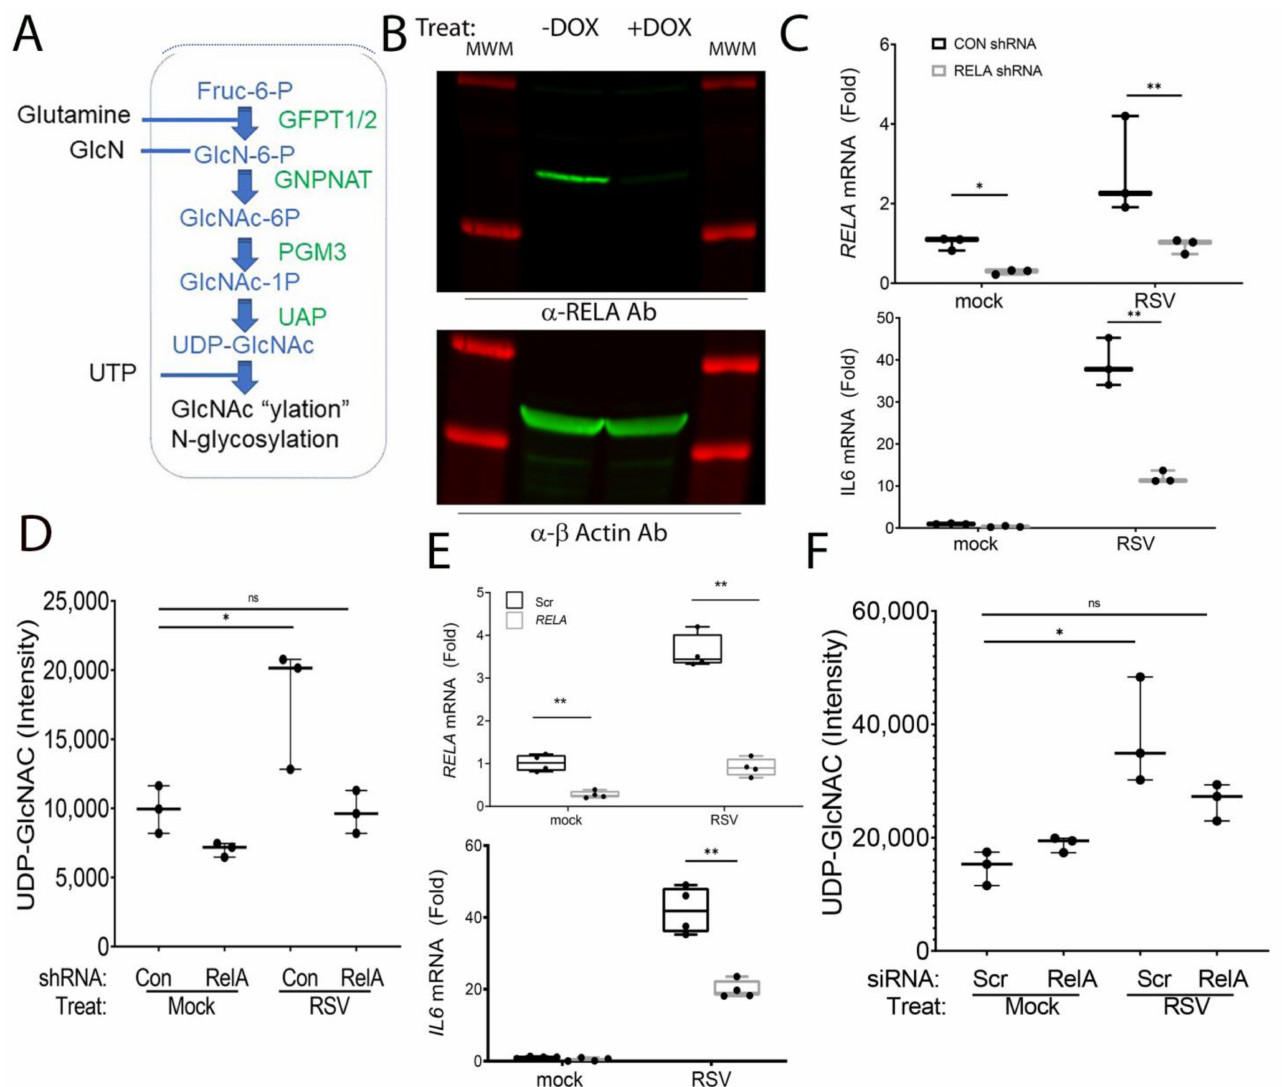
Figure 1. RELA regulates UDP-GlcNAc synthesis. ( A ) Schematic view of the HBP pathway from Fructose-6 phosphate (Fruc-6P) to the formation of UDP-GlcNAc. Metabolites are colored in blue; enyzmes are green. UDP-GlcNAc is a donor for the N-glycosylation of extracellular matrix (ECM) proteins, as well as protein GlcNAc-ylation. Abbreviations are: GFPT, Glutamine-Fructose-6- Phosphate Transaminase; PGM, phosphoglucomutase; UAP, UDP-N-Acetylglucosamine Pyrophos- phorylase; and GNPNAT, Glucosamine-Phosphate N-Acetyltransferase. ( B ) Western blot of RELA in doxycycline-regulated hSAECs. Cells were cultured in the absence (-) or presence (+) of DOX before whole cell lysis. Top panel, anti-RELA staining (green); bottom panel, β -actin staining (green) as housekeeping control. The prominent 65kDa RELA staining is depleted after DOX treatment. MWM, molecular-weight markers (red). ( C ) qRT-PCR. Cells cultured in the absence or presence of DOX were mock-infected or RSV-infected for 24 h prior to qRT-PCR. Data are expressed as a fold change of the untreated control, normalized to PP1A. Each symbol is a biological replicate ( n = 3). Top panel, RELA mRNA; bottom panel, IL6 mRNA. Data are significant by ANOVA. **, p < 0.01 by post-hoc Tukey comparison. ( D ) Cytoplasmic UDP-GlcNAc abundance. Cells were treated as in panel ( C ), and total cellular UDP-GlcNAc was measured by LC-MS/MS. *, p < 0.01. ( E ) qRT-PCR of RELA depleted hSAECs by siRNA. hSAECs were transfected with scrambled (Scr) or RELA-targeting siRNA. Top panel, fold change of RELA mRNA; bottom panel, IL6 mRNA. ( F ) UDPG-GlcNAc in siRNA- transfected cells. Intracellular UDP-GlcNAc was measured in control siRNA or RELA-siRNA transfected cells in the absence or presence of RSV infection. *, p < 0.01; ns, not